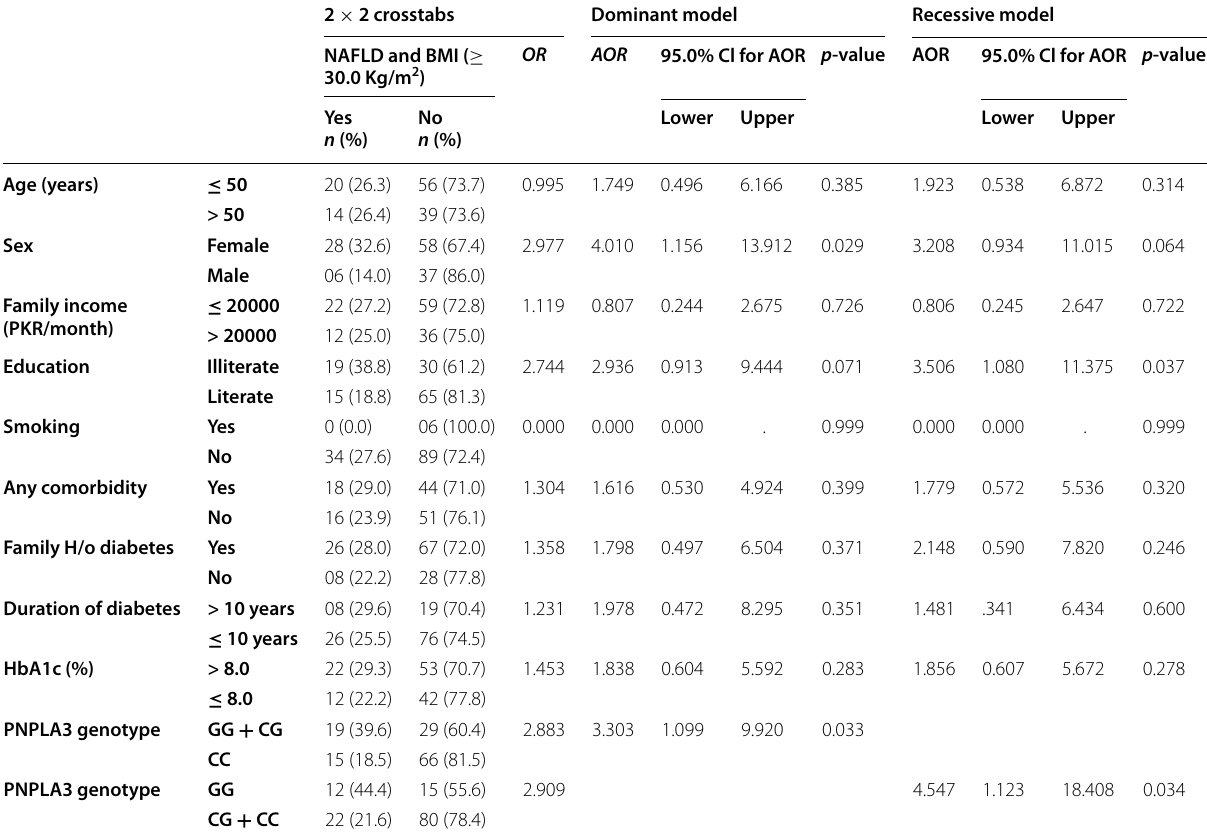
Table 4 Binary logistic regression for NAFLD in obese T2DM patients under dominant and recessive models ( n